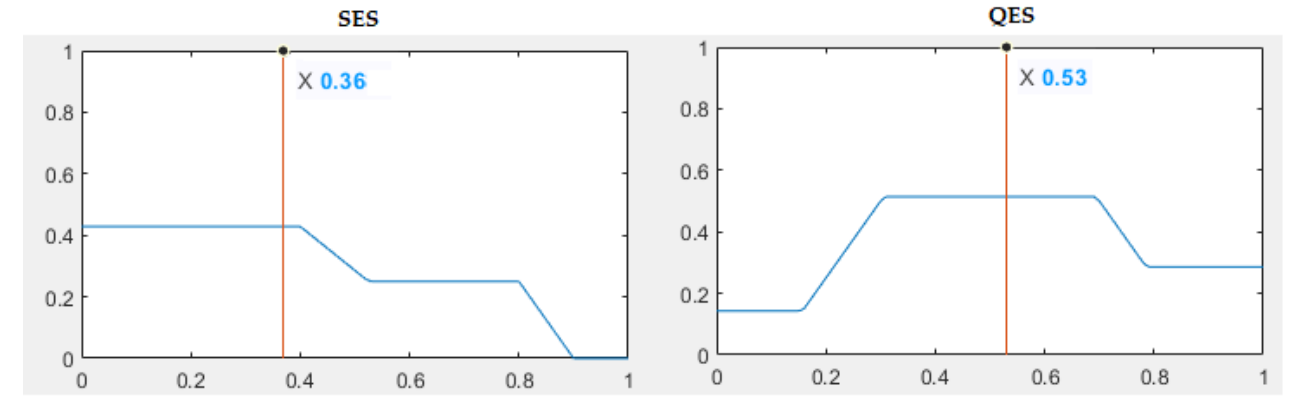
Figure 1. Integral equivalence between SES, QES and handwritten signature.